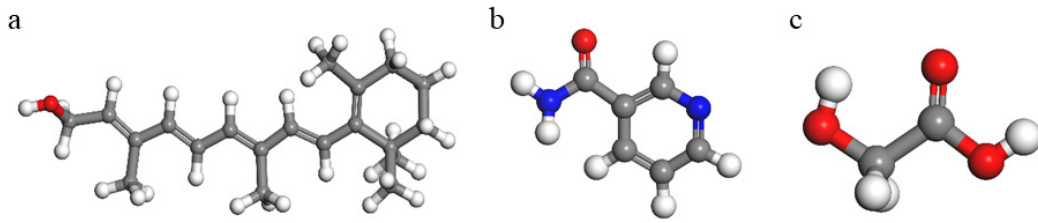
Figure 1. Optimized molecular structures of retinol ( a ), niacinamide ( b ) and glycolic acid ( c ).